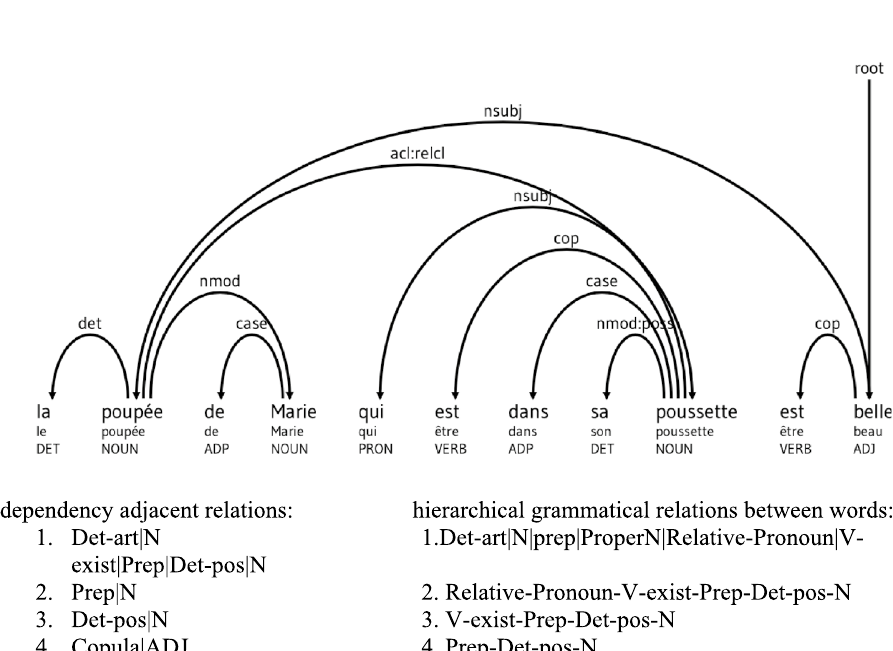
Figure 6. Syntactic tree from dependency grammar (French Meta Grammar http:// alpage. inria. fr/ frmgd emo) 73